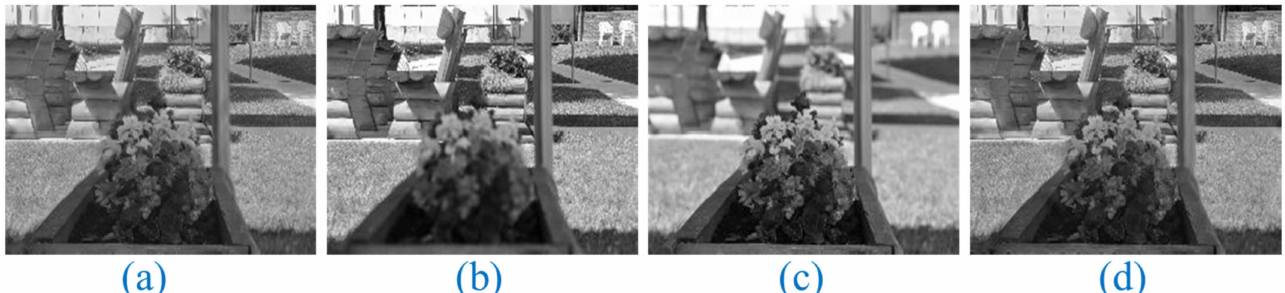
Figure 6. Multi-focus image of a grass from various perspectives. Original Image: ( a ), Multi-focus Input Images: ( b , c ), and Proposed Fusion: ( d